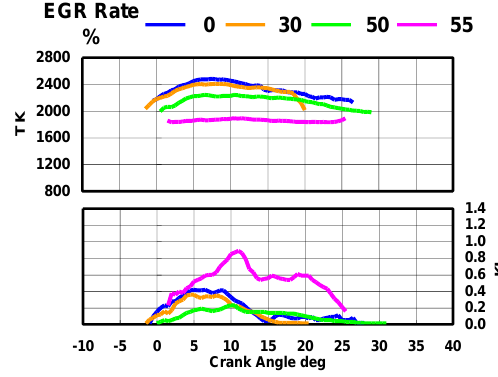
Fig. 14. Averaged Tb and KL factor by changing EGR rates